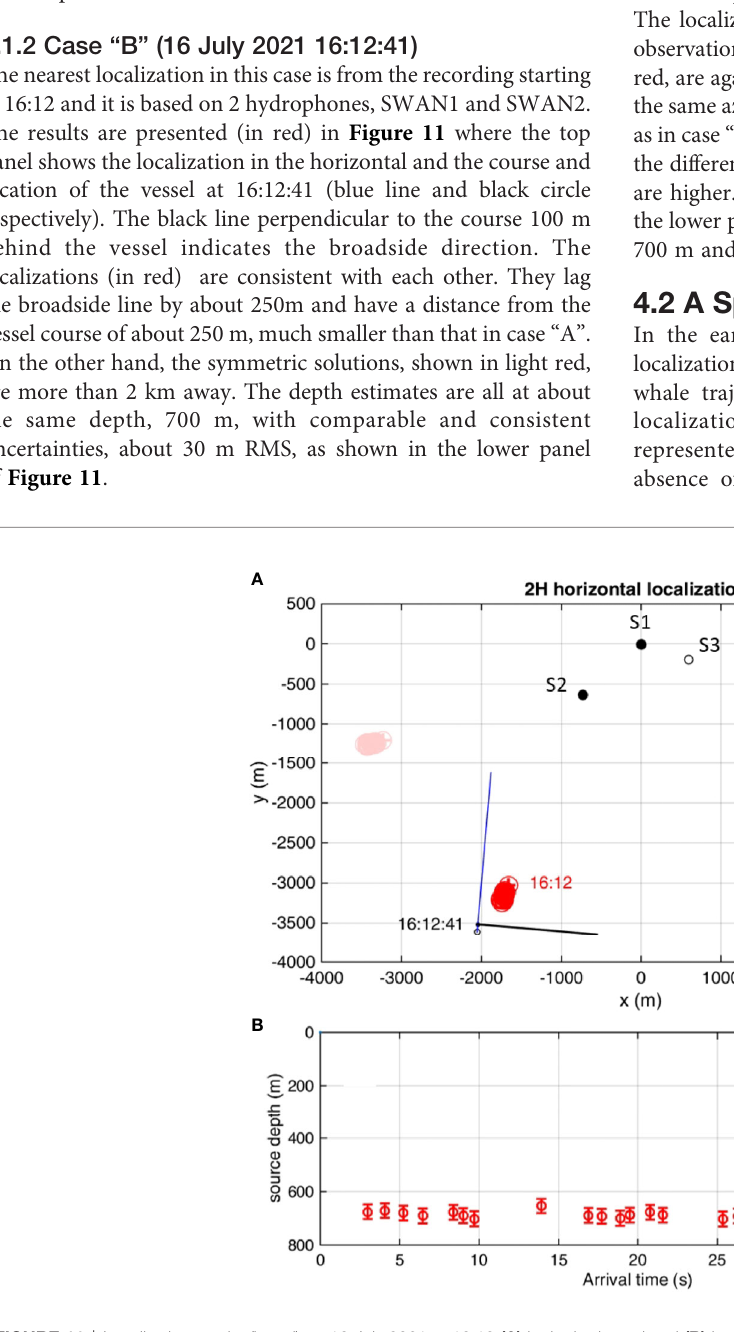
FIGURE 11 | Localization results (in red) on 16 July 2021 at 16:12 (A) in the horizontal and (B) in the vertical based on receptions at SWAN1 and SWAN2 hydrophones. The symmetric solutions in the horizontal are also shown (light red) in (A) . The blue line and the open circle in (A) show the vessel course and position, respectively, at 16:12:41; the black line shows the broadside direction of the towed array of